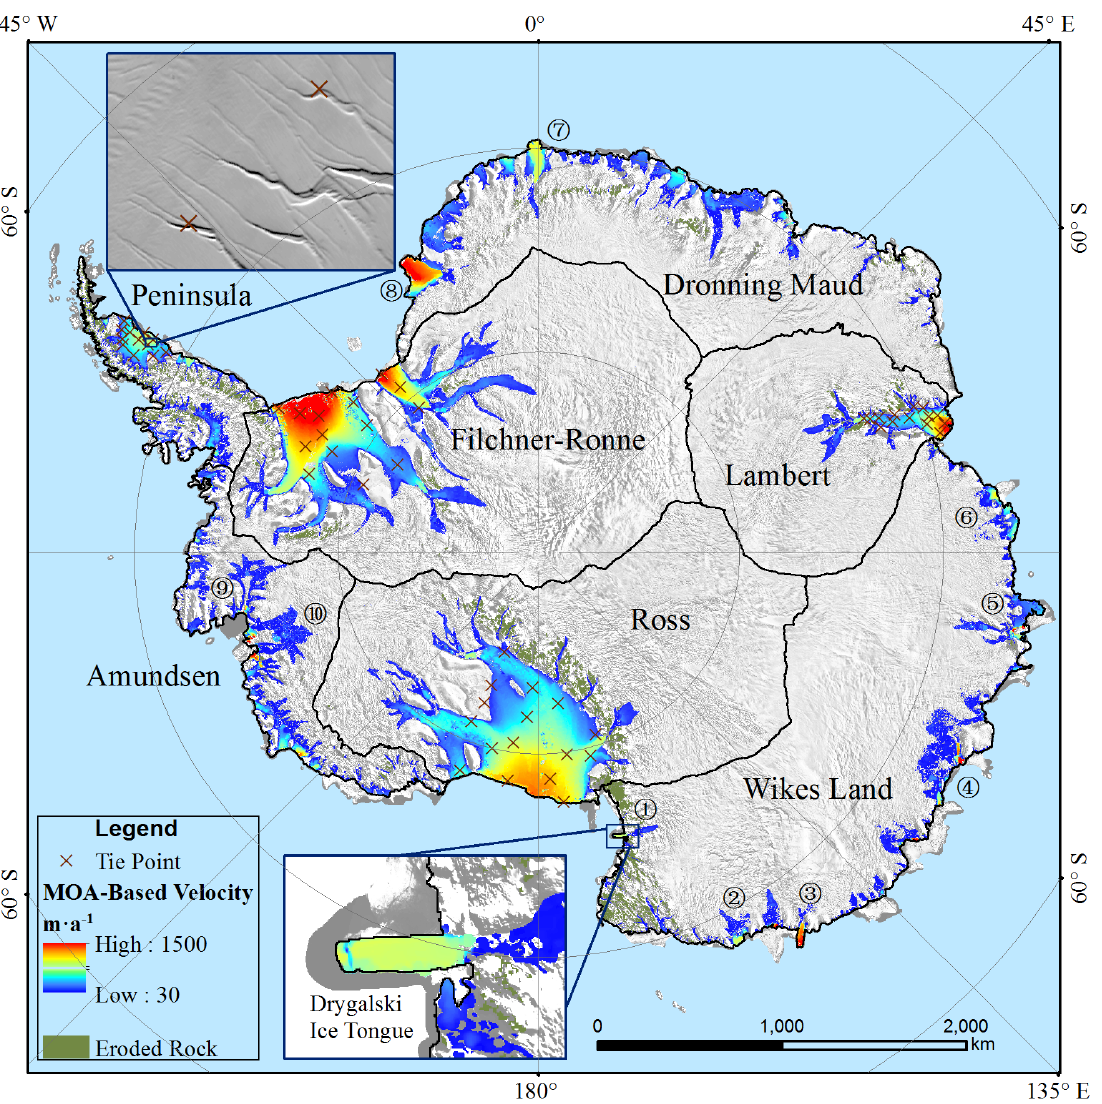
Figure 2. MOA-based Antarctic Surface Ice Velocity with stretched MOA 2009 as background, the seven divisions are combined from Zwally’s 2012 Antarctic Drainage System [60] (their names are just for notation in latter analysis, rather than exact demarcation of geographical entities), Landsat-8 Rock Outcrop areas, and all tie-points distribute all over the continent. Brown enlarged cross mark exemplify two neighboring tie-points in surface crevasse of the Larsen-C shelf in the close-up above. The floating velocity field of Drygalski Ice Tongue is enlarged in the close-up below. Digital numbers denote glaciers and ice shelves discussed in Section 4: 1 (cid:13) the Drygalski Ice Tongue, 2 (cid:13) the Cook Ice Shelf, 3 (cid:13) the Mertz Ice Tongue, 4 (cid:13) the Totten Glacier, 5 (cid:13) the Shackleton Ice Shelf, 6 (cid:13) the West Ice Shelf, 7 (cid:13) the Fimbul Ice Shelf, 8 (cid:13) the Brunt Ice Shelf, 9 (cid:13) the Pine Island Glacier, and 10 (cid:13) the Thwaites